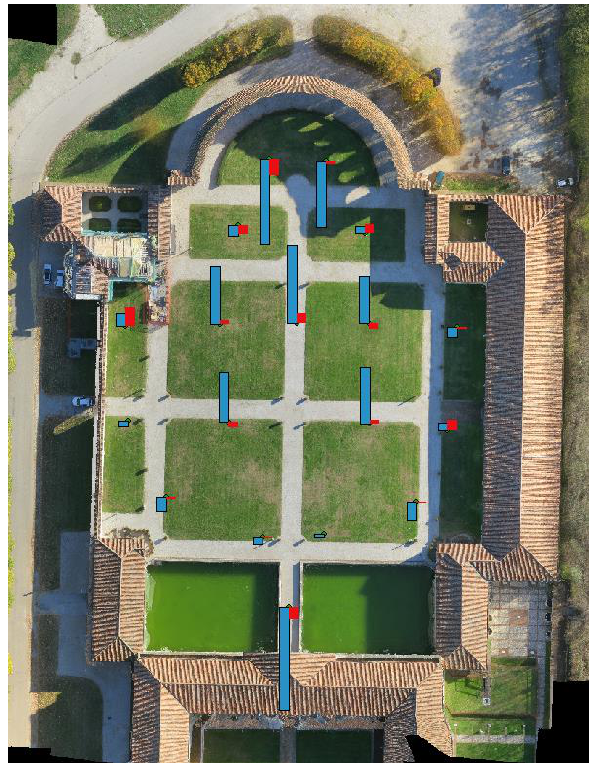
Figure 3. Orientation residual distribution, blue ones before optimization, red ones after optimization.